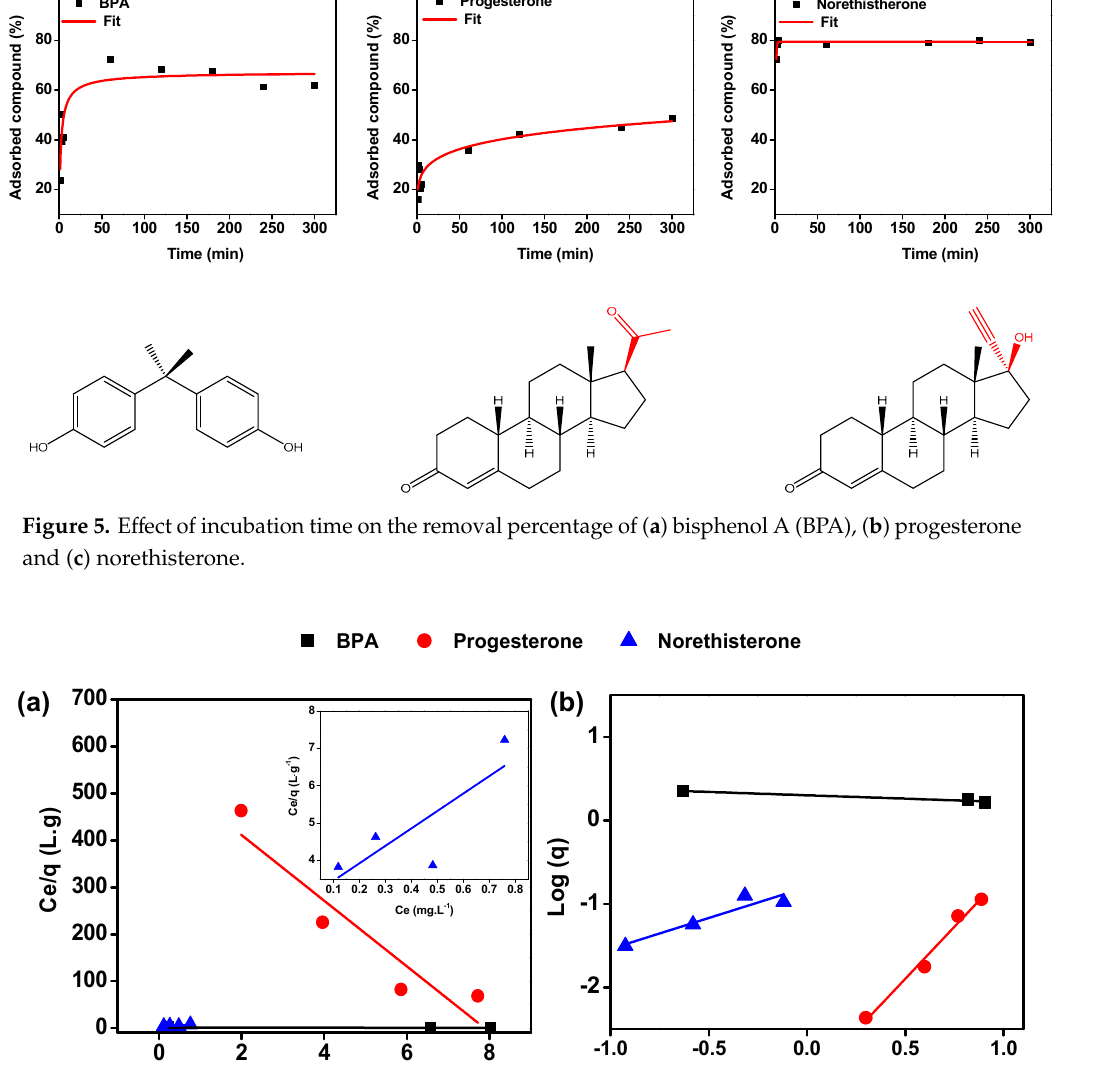
Table 1. Isotherm parameters for adsorption of BPA, progesterone and norethisterone by the GO– PEI–FeNPs composite.